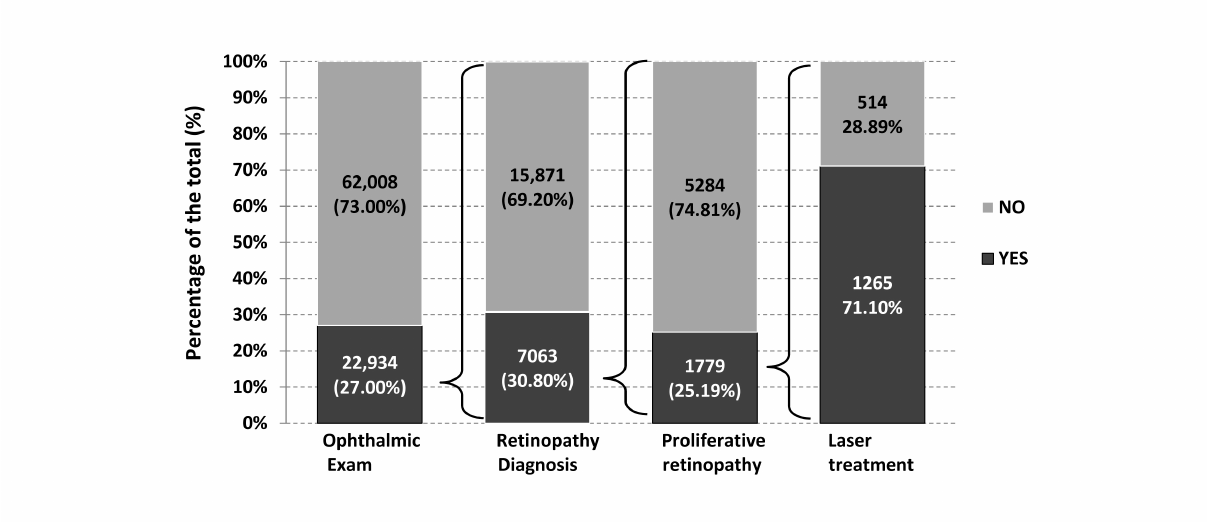
Figure 7. The ophthalmic exam coverage and retinopathy diagnosed patients with proliferative retinopathy and those who received or missed laser therapy among the total registered